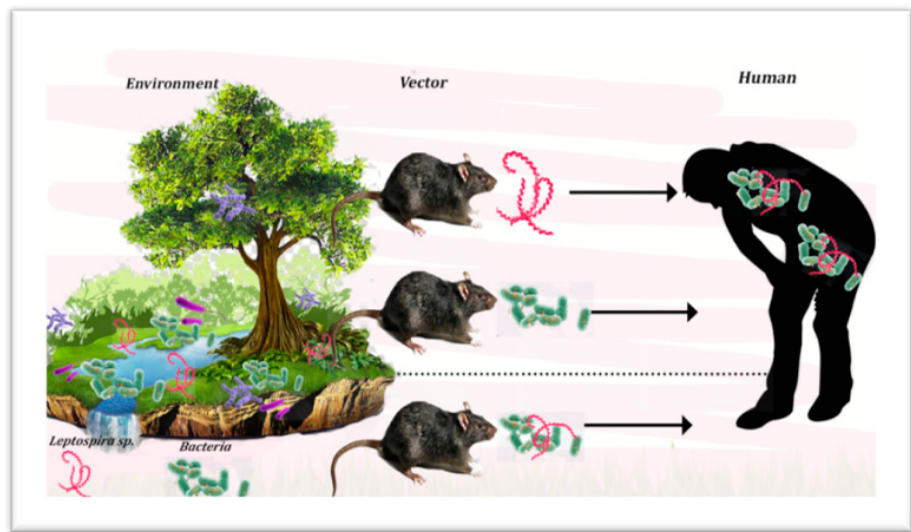
Figure 1. Environment and vector infections occur as a result of coinfections in